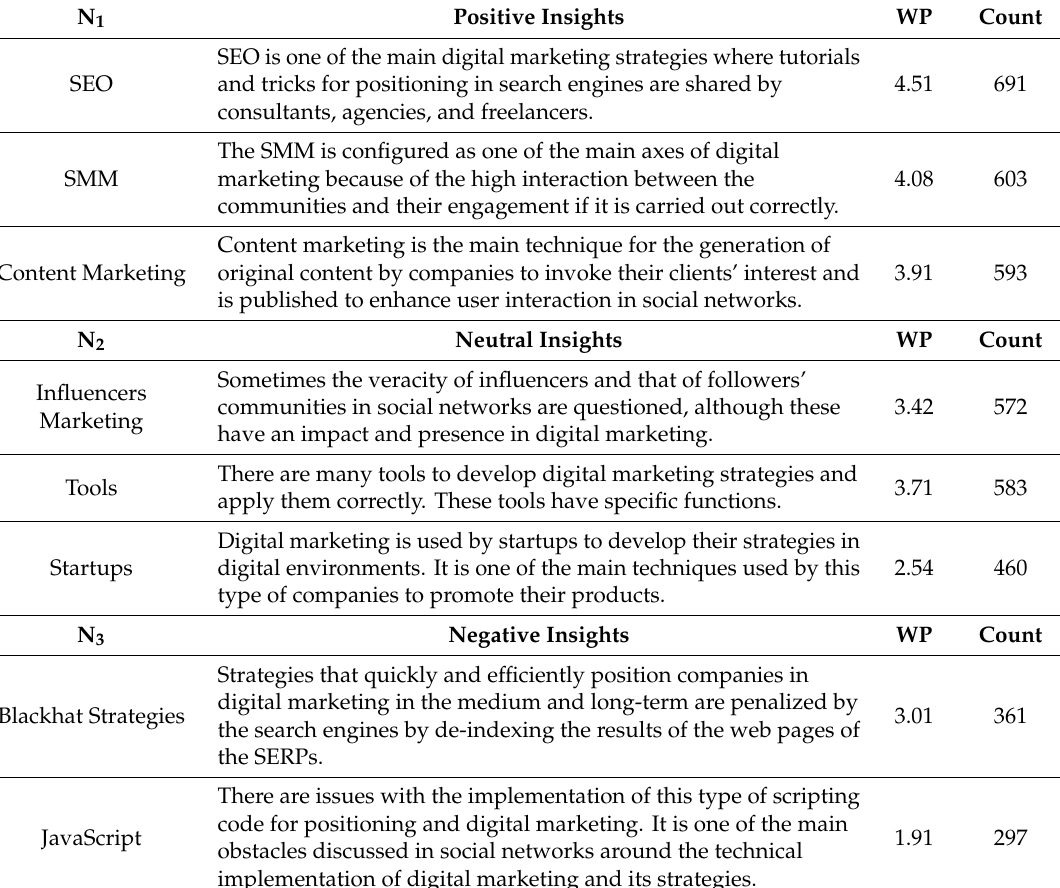
Table 3. Results for N 1 –N